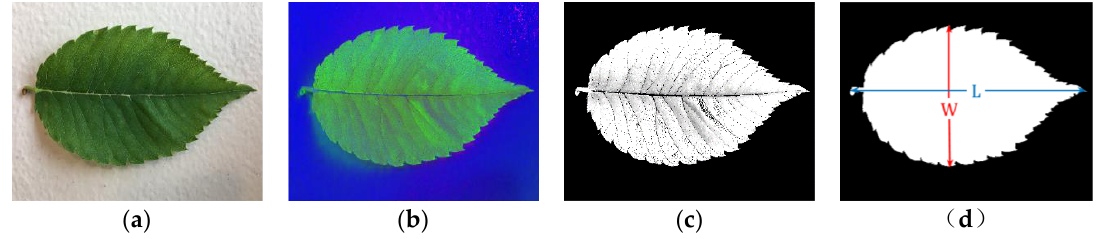
Figure 2. Extraction from an image of a leaf (adapted from [4]): ( a ) original photograph; ( b ) conversion from RGB to HSV format to serve as a guide for subsequent edge detection; ( c ) grayscale conversion to improve image contrast; and d) feature extraction after identifying leaf boundaries.